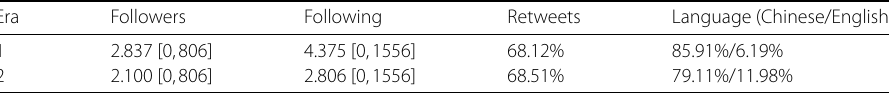
Table 1 Descriptive statistics for Chinese state-sponsored accounts. Statistics for Followers and Following are given as the mean and the range in brackets. Percentages are provided for retweets in each era, as well as percentage of tweets in Chinese/English. The remaining minority of tweets were in other languages or were not identified by Twitter Era Followers Following Retweets Language (Chinese/English)